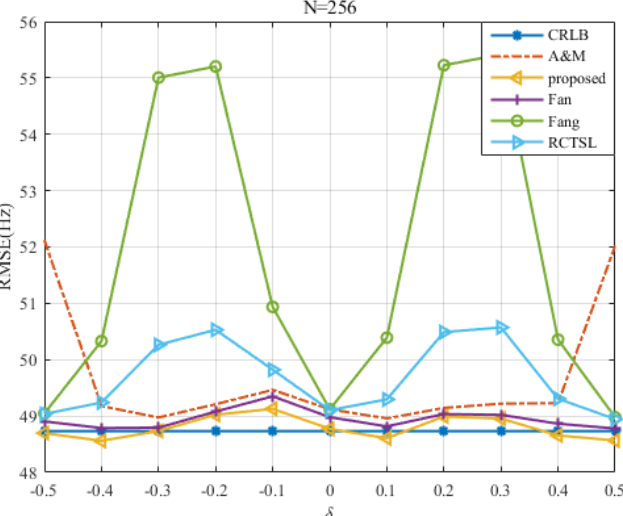
Figure 11. RMSE comparison among the frequency estimates versus δ at N = 256 and SNR = 0 dB.